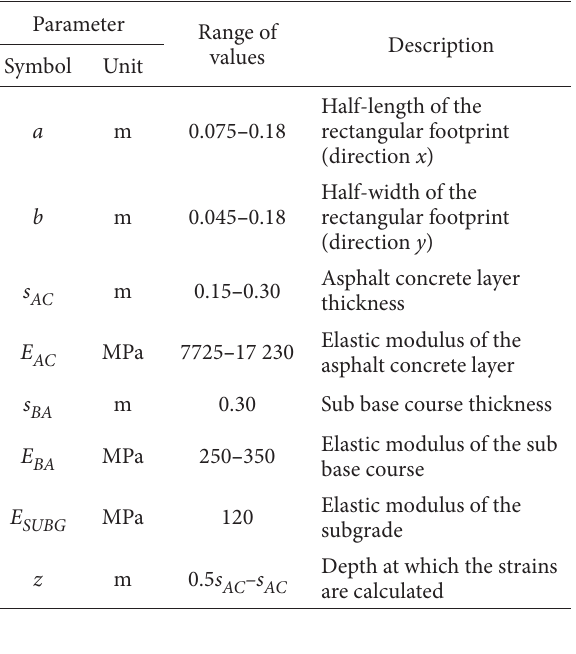
Table 1. Parameters used in simulations and range of variation